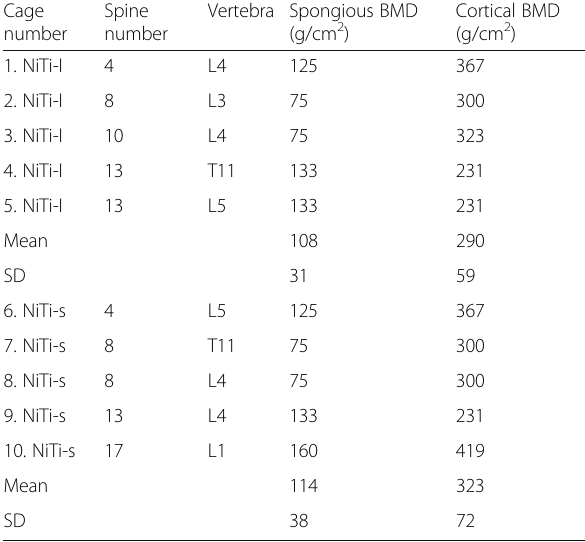
Table 1: Characteristics of the specimens Cage Spine number